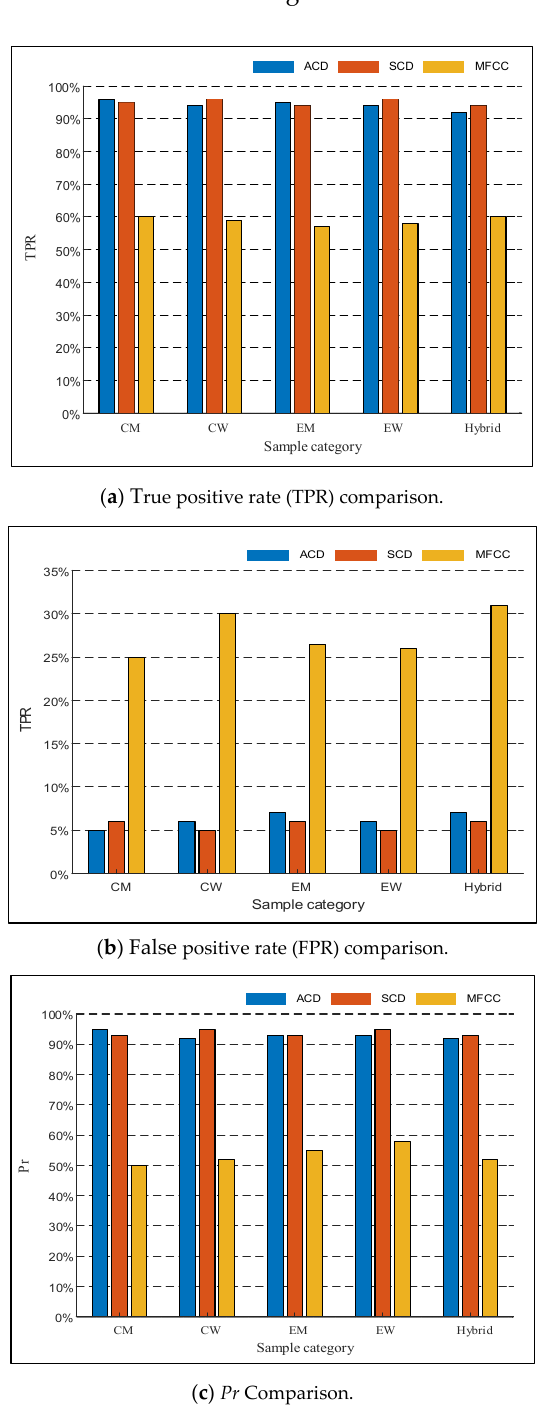
Figure 7. Comparison of detection algorithms.